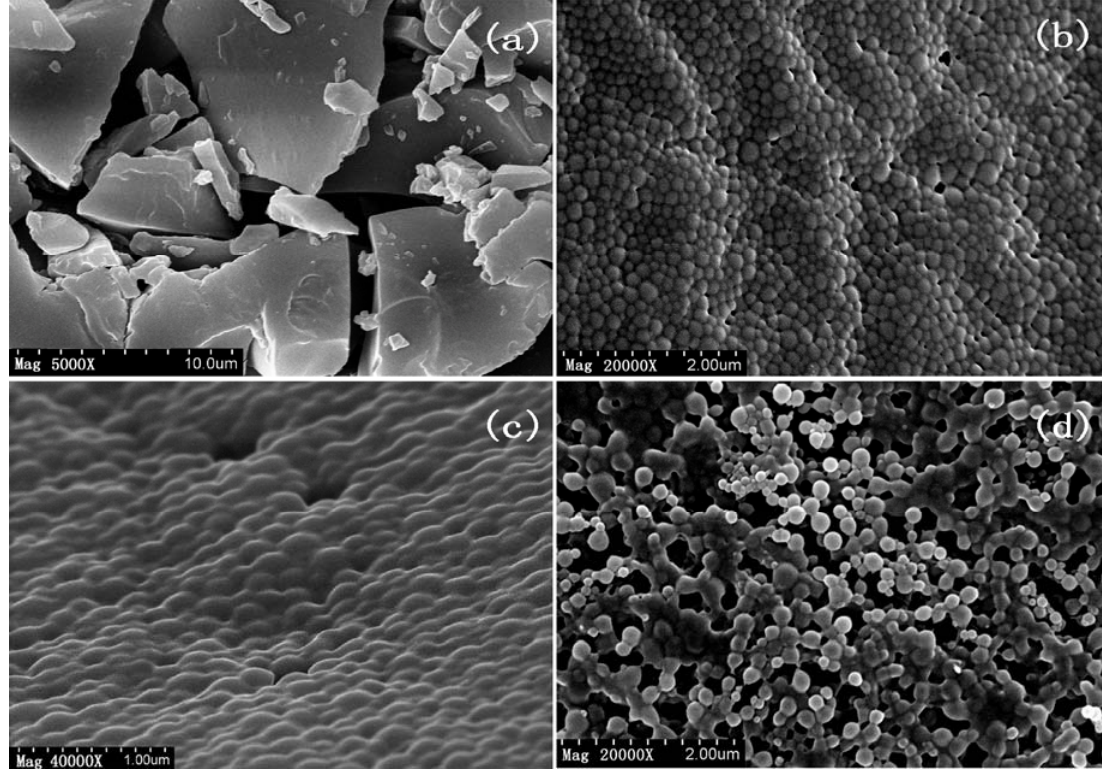
Figure 3. Scanning electron microscopy (SEM) image of raw VLBT and VLBT-loaded nanoparticles. ( a ) Raw VLBT; ( b ) VLBT-BSANPs; ( c ) Fa-BSANPs-VLBT; ( d ) Fa-BSANPs-VLBT with